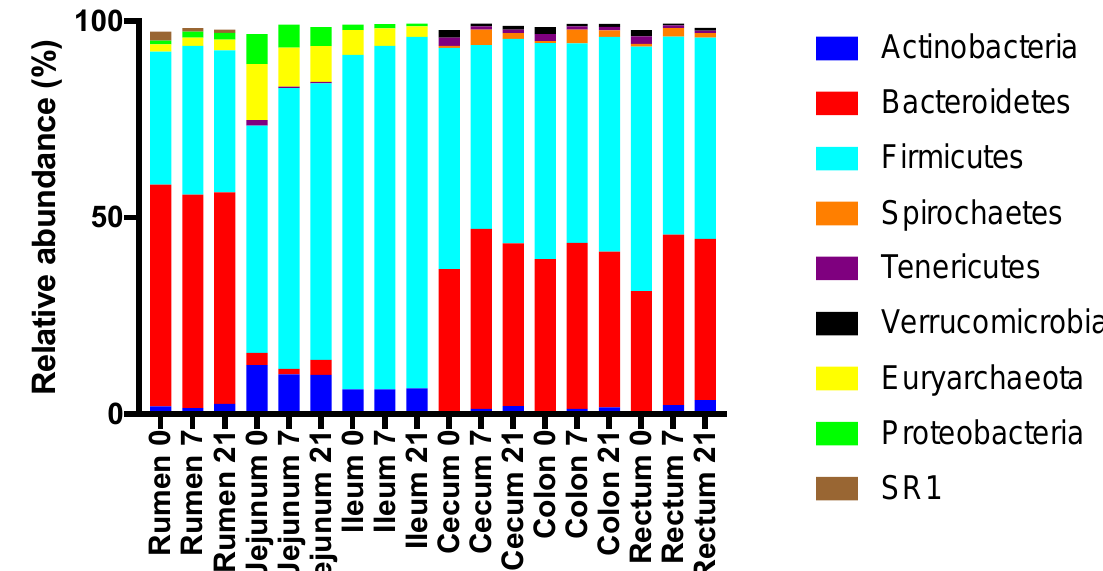
Figure 5. Effect of the duration of feeding a moderate grain diet (0, 7, or 21 d) and region of the digestive tract on the relative abundances of abundant phyla.